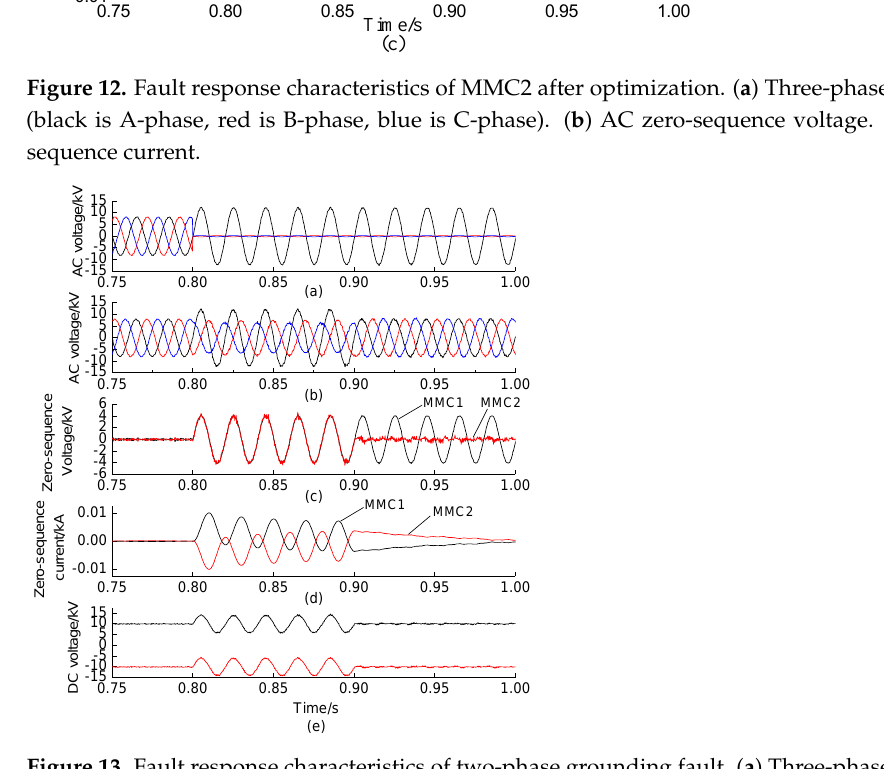
Figure 12. Fault response characteristics of MMC2 after optimization. ( a ) Three-phase AC voltage (black is A-phase, red is B-phase, blue is C-phase). ( b ) AC zero-sequence voltage. ( c ) AC zero-se- quence current.